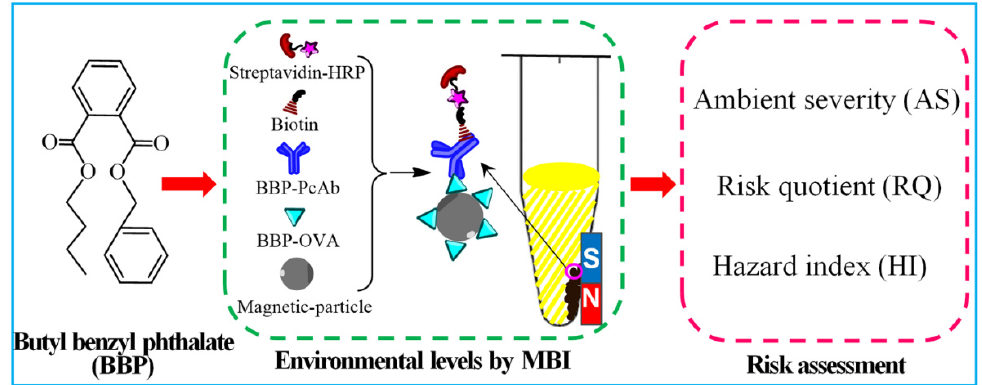
Figure 1. The schematic diagram of MBI method for the environmental levels and risk assessment of BBP.